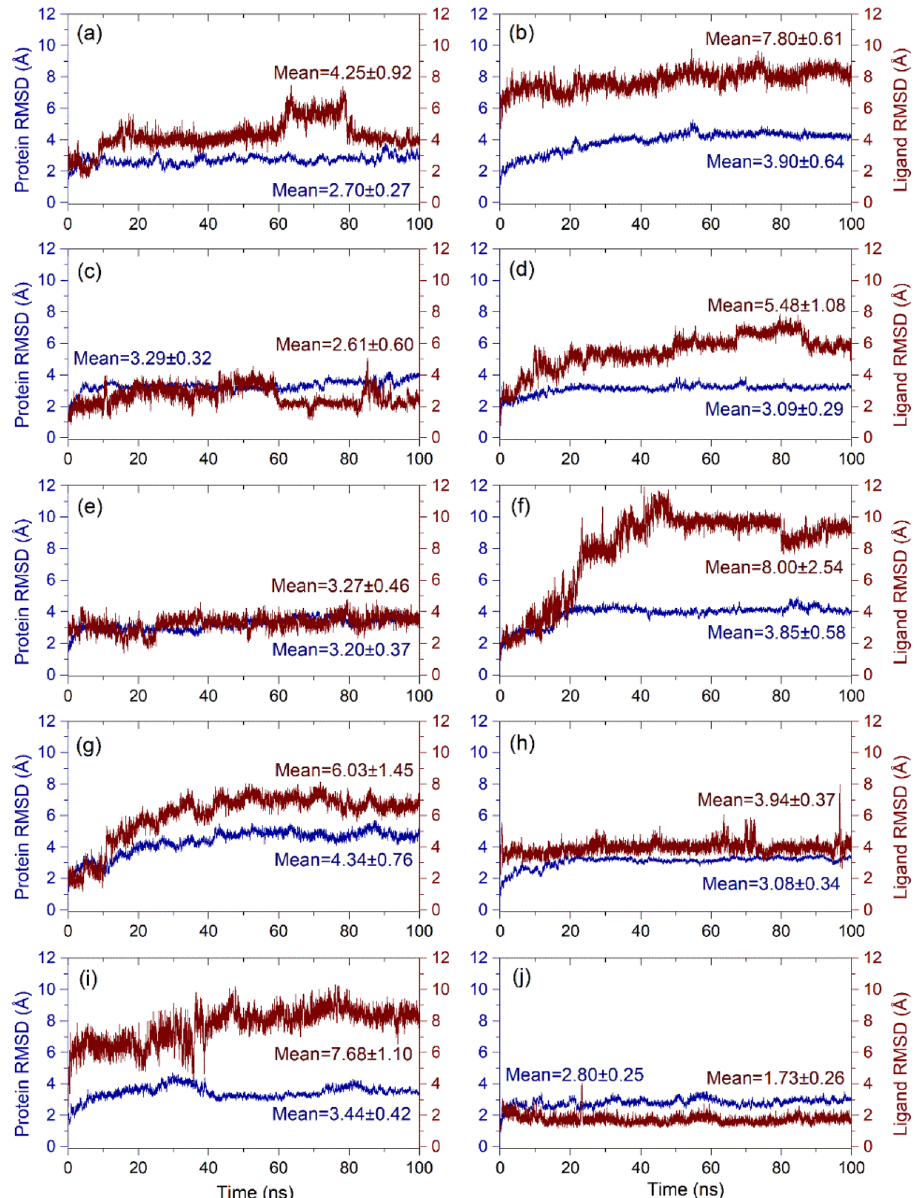
Figure 6. Calculated RMSD values for alpha carbon (Cα) atoms (blue curves) of Sirt2 protein and protein fit ligands (red curves), viz. ( a ) Canagliflozin, ( b ) Flibanserin, ( c ) Ezetimibe, ( d ) Pimozide, ( e ) Fluphenazine, ( f ) Droperidol, ( g ) Osimertinib, ( h ) Pioglitazone, ( i ) Formoterol, and ( j ) Nintedanib, were plotted with respect to 100 ns simulation